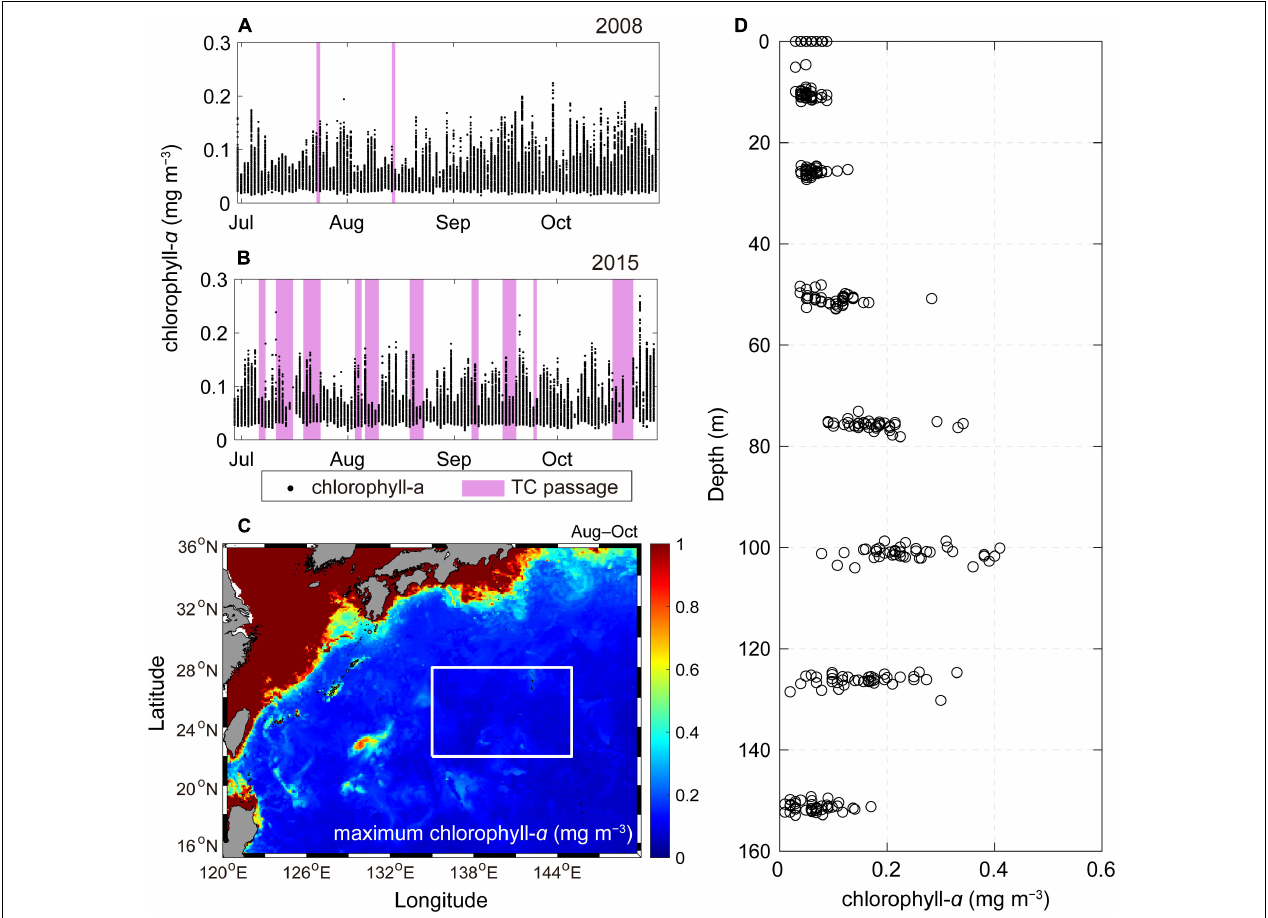
FIGURE 5 | The chlorophyll- a distributions (mg m − 3 ) during the TC season in the study region (22 ◦ N–28 ◦ N, 135 ◦ E–145 ◦ E) in (A) 2008 and (B) 2015. The pink shading in (A,B) represents periods of TC passage. (C) Maximum values of summer (August–October) chlorophyll- a concentrations (mg m − 3 ) over the 11 study years (2007–2017). Note that the maximum chlorophyll- a value of 0.9 mg m − 3 observed in October 2012 outside of the study area (around 23 ◦ N and 130 ◦ E) represents the high end of the chlorophyll- a elevation caused by TC passage in the nutrient-depleted subtropical North Pacific Ocean. The substantial increase of chlorophyll- a was mainly due to the longer duration ( ∼ 1 week) and high maximum sustained wind speed ( < 46.3 m s − 1 ) of TC “Prapiroon”. (D) The vertical distributions of the chlorophyll- a concentration in the study area (white solid rectangle) during summer obtained from the GLODAP v2 dataset (Olsen et al.,